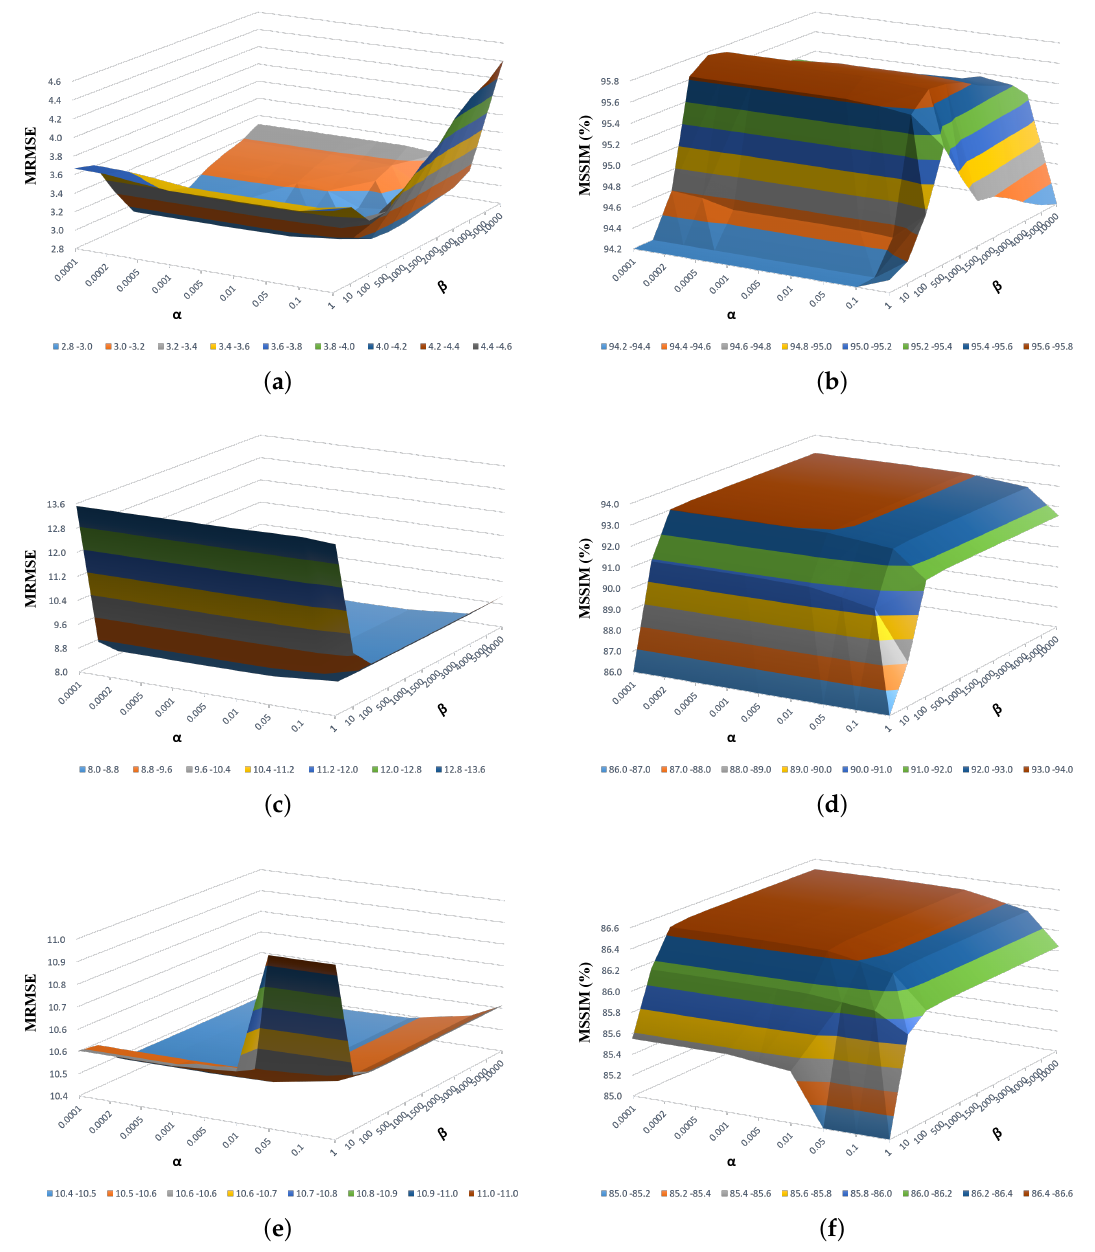
Figure 5. Mean Root-Mean-Squared Errors (MRMSEs) and Mean Structure Similarities (MSSIMs) versus the value of parameters α and β using the proposed method with a magnification factor of three. ( a ) MRMSEs versus α and β on the CAVE dataset. ( b ) MSSIMs (in terms of percentage) versus α and β on the CAVE dataset. ( c ) MRMSEs versus α and β on the Pavia dataset. ( d ) MSSIMs (%) versus α and β on the Pavia dataset. ( e ) MRMSEs versus α and β on the Paris dataset. ( f ) MSSIMs (%) versus α and β on the Paris